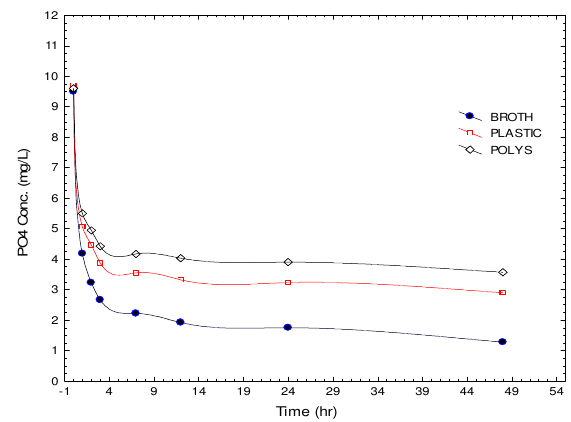
Fig. 20. Effect of Packing type on the concentration level of PO 4 pollutant with time at T=25 o C, pH 7, and sterilized